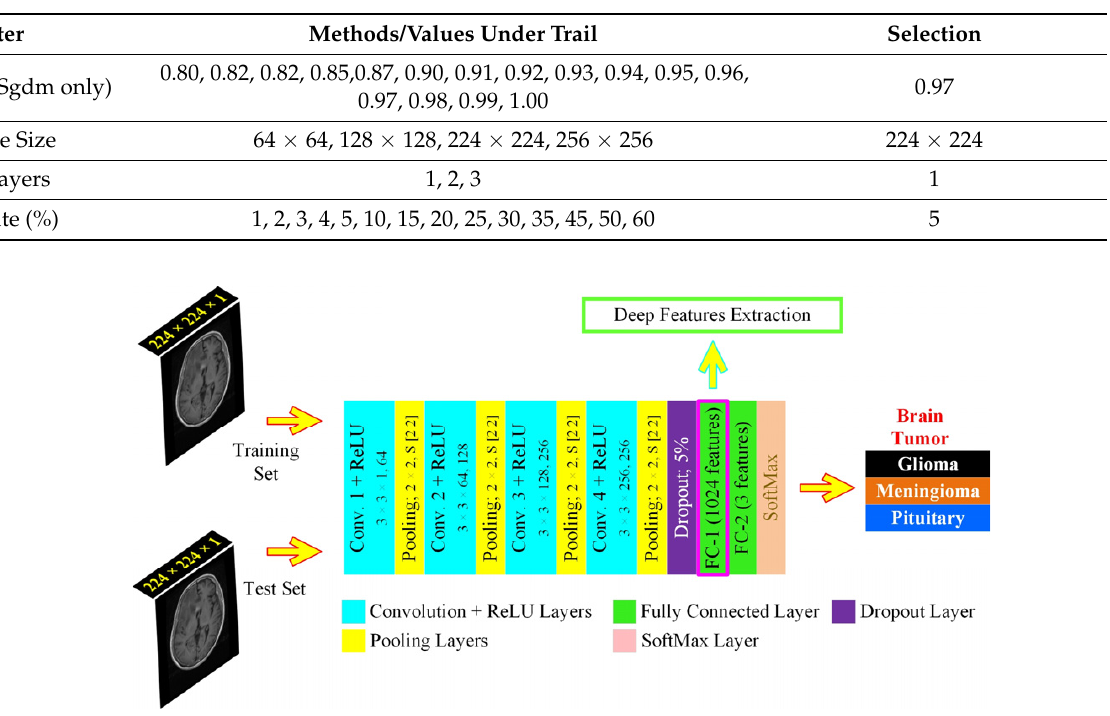
Figure 5. The proposed Ultra-Light Deep Learning Architecture (UL-DLA) for deep features’ extrac-